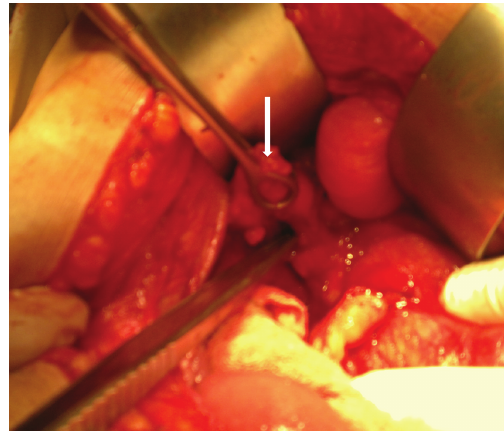
Figure 3: Peroperative image shows the excised fistula